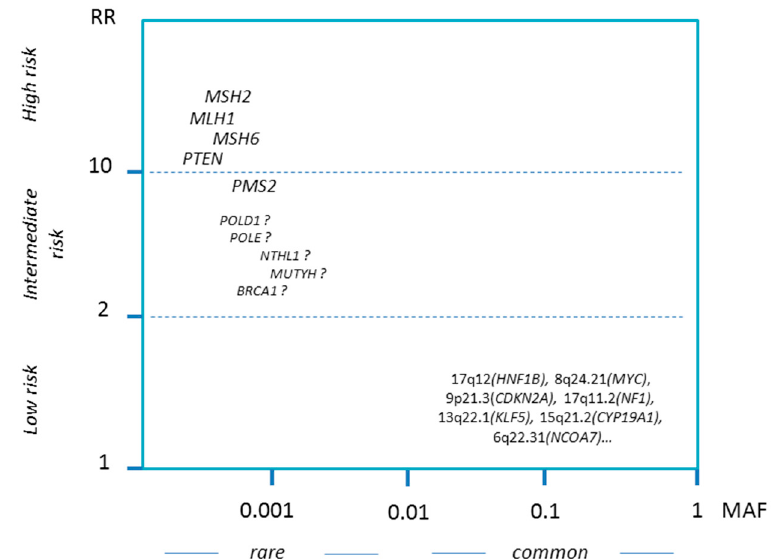
Figure 1. Schematic illustration of hereditary risk factors with risk estimates plotted against frequency. RR, relative risk; MAF, minor allele frequency. Risk estimates refer to classical pathogenic variants and may vary depending on the nature of the specific gene variant. Candidate intermediate risk factors are indicated with question mark (see Section 1.3 for further discussion). Low-risk genome-wide case-control association studies (GWAS) loci are indicated by their chromosomal region with plausibly predicted nearby genes given in brackets. MAF values refer to the abundance of loss-of-function variants estimated from the gnomAD database (https: // gnomad.broadinstitute.org / ). As a note of caution, these MAFs may substantially di ff er between distinct populations, some missense variants are not covered and only a subgroup of variants in POLD1 and POLE may cause cancer (see Section 1.3.4). Figure not drawn to scale.